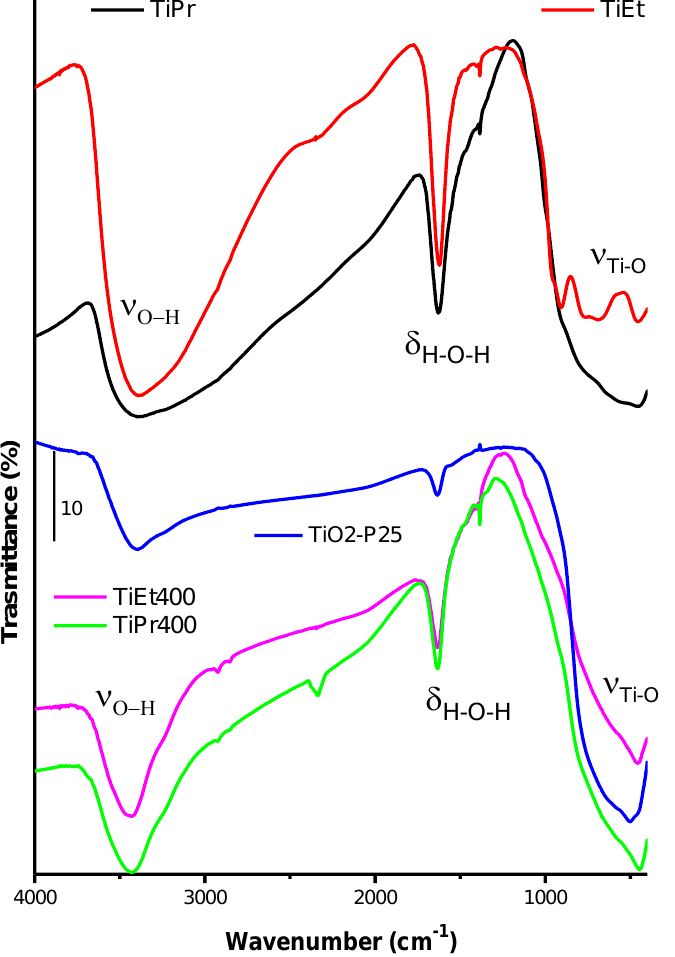
Figure 2. FT-IR spectra of the precursor alkoxides ( top ), the calcined solids TiEt400 and TiPr400 ( bottom ) and of TiO 2 -P25 ( middle